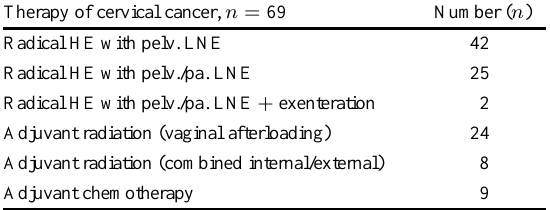
Distribution of therapy modalities in patients with primary cervi- cal cancer. Only patients were mentioned, that could be included in prospective analysis ( n = 69). HE = hysterectomy, LNE = Lymphonodectomy, pelv. = pelvic, pa. = paraaortic Therapy of cervical cancer, n =